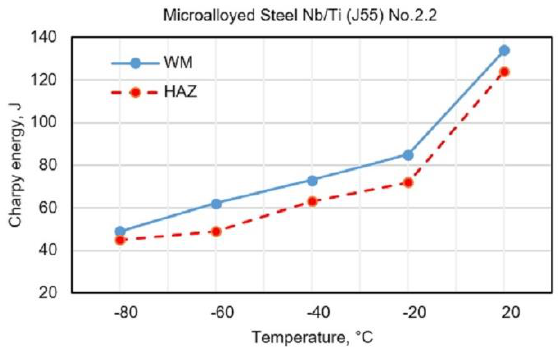
Figure 5. Test results of impact energy at test temperatures of welded joints made with electrode No.2.1.